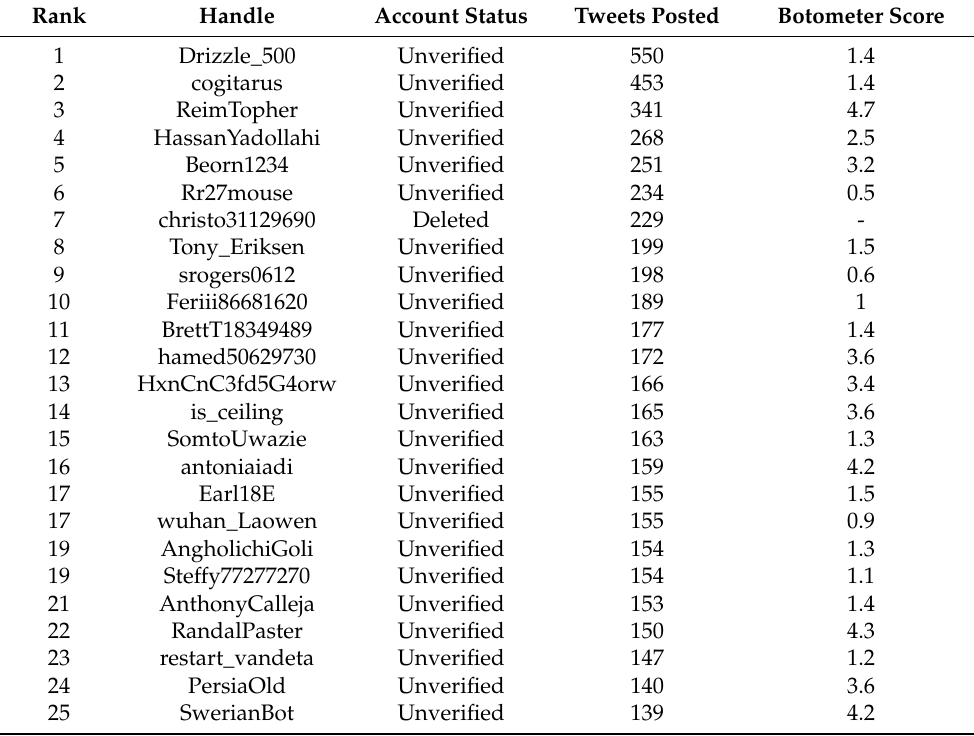
Figure 1. Distribution of tweets and unique users mentioning #maga or #trump2020 between 27 October and 2 November 2020. The blue dots and line represent the daily number and the trend of tweets, while the red dots and line represent the daily number and the trend of unique users. Table 1. The 25 most active